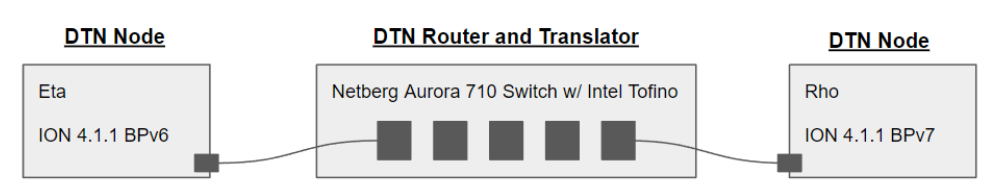
Figure 7. Physical configuration of setup.